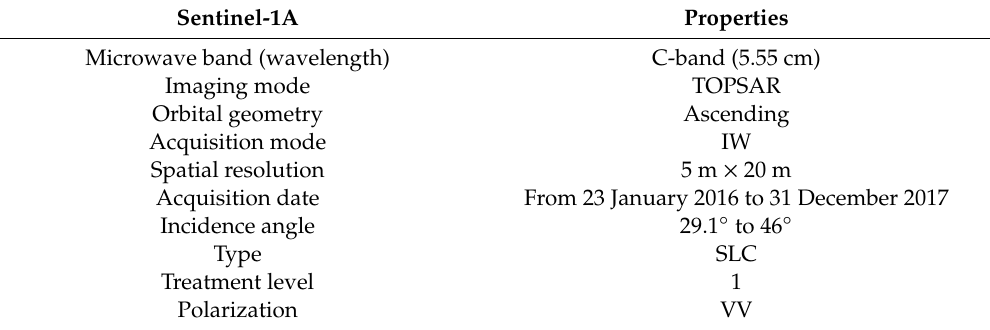
Table 2. Properties of the Sentinel-1A SAR images collected for the Mailuu-Suu area and used in this